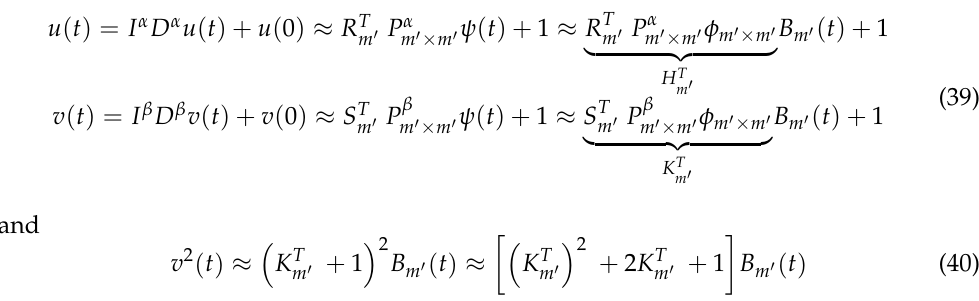
() v t () u t and for several m  values